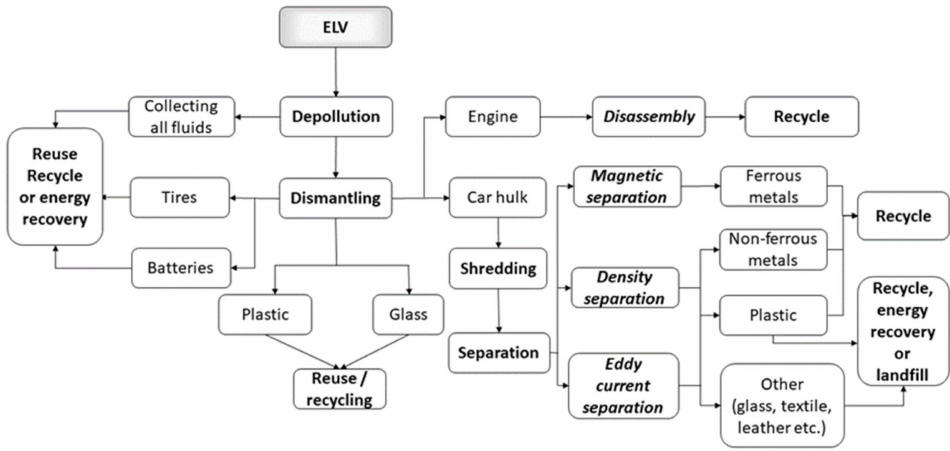
Figure 4. ELV management in Romania. Figure made by authors based on